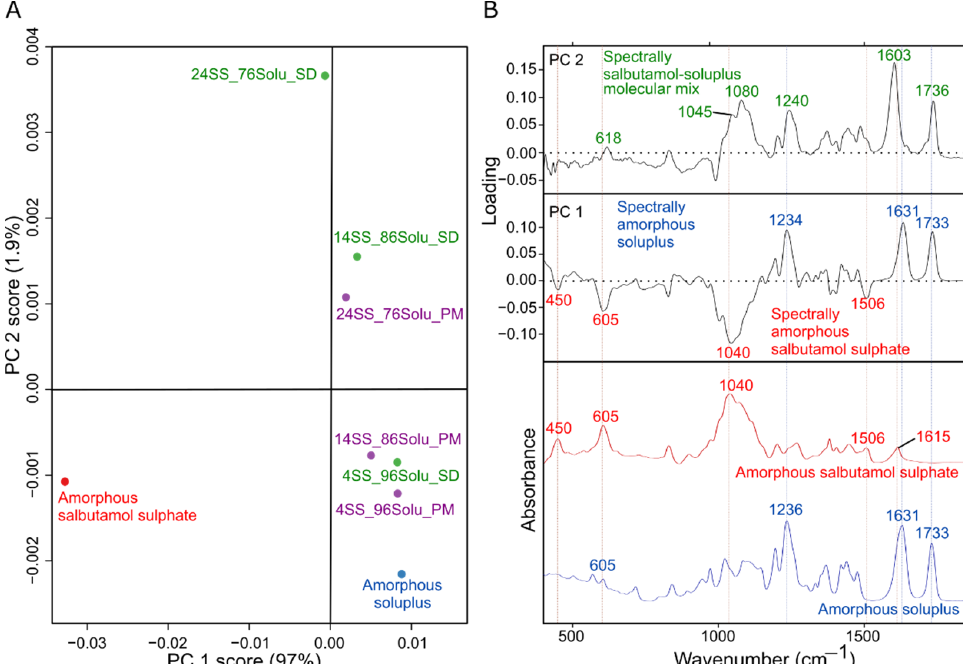
Figure 4. The principal component analysis of the FTIR spectral data of amorphous salbutamol sulfate, amorphous soluplus, and their spray-dried formulations (4SS_96Solu_SD, 14SS_86Solu_SD, and 24SS_76Solu_SD) and physical mixtures (4SS_96Solu_PM, 14SS_86Solu_PM, and 24SS_76Solu_PM) in the ratios of 4:96, 14:86, and 24:76. ( A ) Score plot of the spectral data. ( B ) Loading plots with FTIR spectra of amorphous salbutamol sulfate and amorphous soluplus as references.